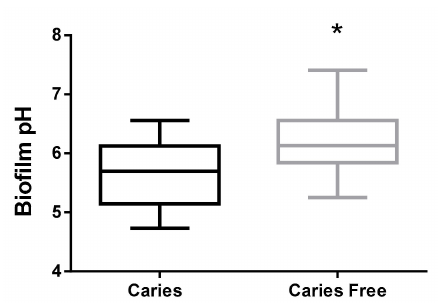
Figure 1. Boxplot graphics of biofilm pH, expressed as pH units of caries and caries-free children. ( p = 0.0005, Mann Whitney test). * Means statistically significant di ff erence between groups.